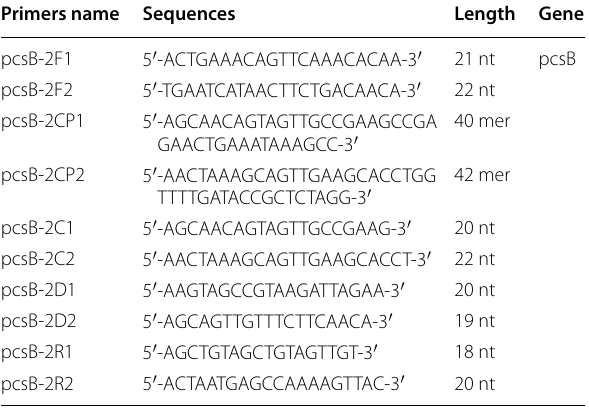
nt nucleotide, mer